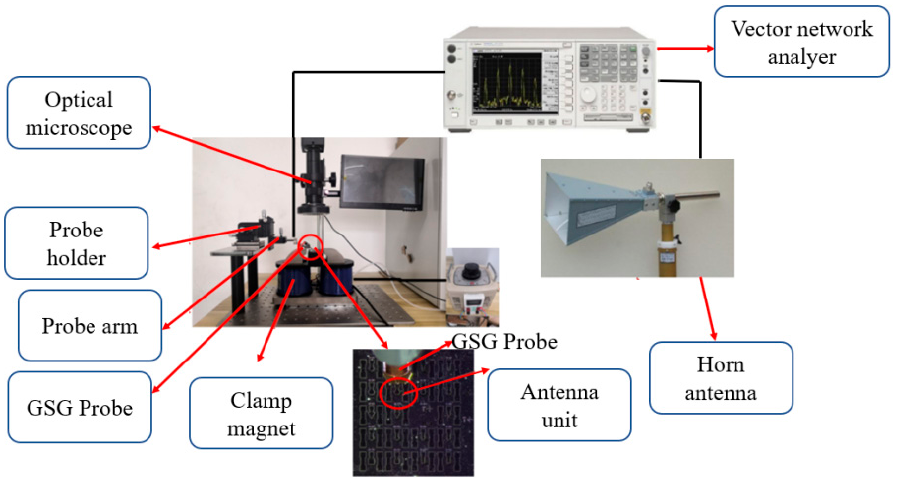
Figure 14. Testing platform.